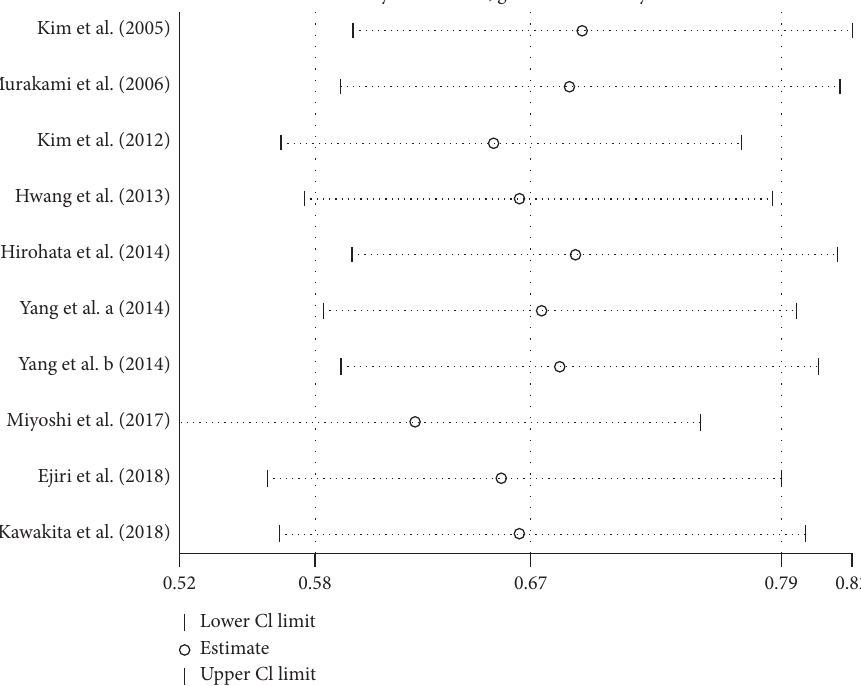
Figure 10: Comparison of PMI between the experimental group and the control group (sensitivity analysis). RR � risk ratio; PMI � periprocedural myocardial